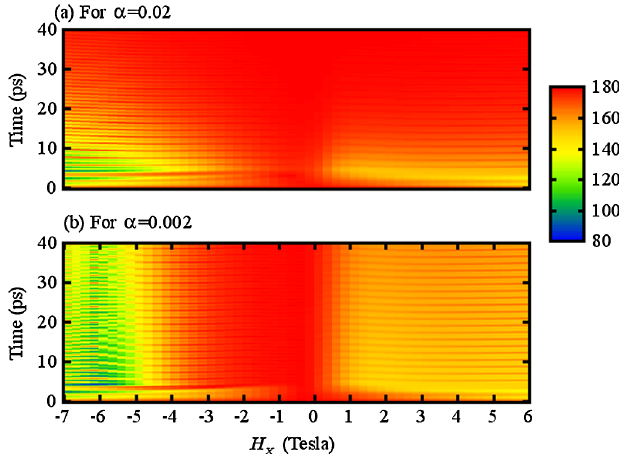
FIG. 4. Evolution of the angle between the sublattice magnet- izations: (a) for a damping factor of 0.02, and (b) with a damping factor of 0.002. In the simulations, the x component to the applied field was varied, whereas the z component was kept constant, H z ¼ 5 T , also j K j ¼ 0 : 06 mRy .